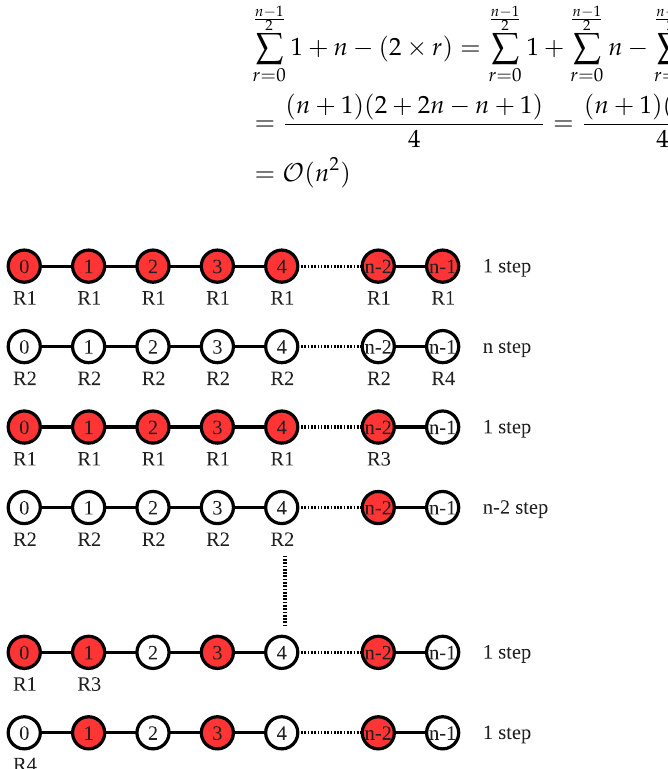
Figure 6. Worst-case scenario for the SS-CVC 1